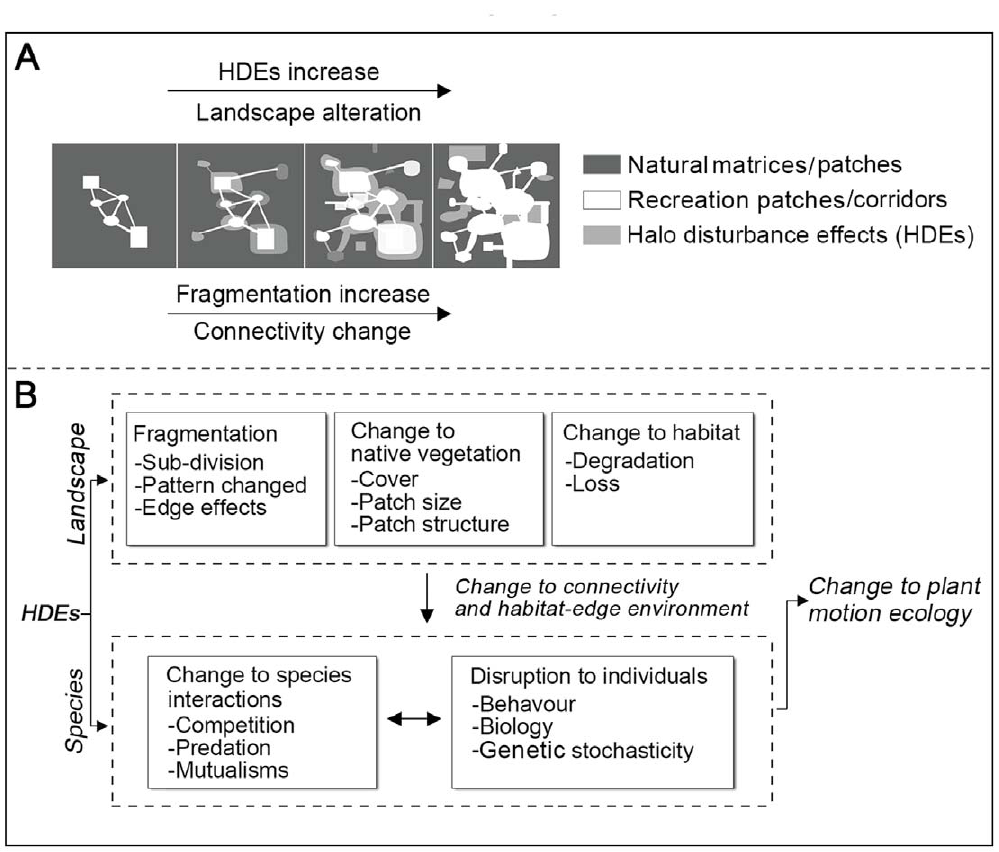
Figure 1. Conceptual framework of ‘‘Halo disturbance effects (HDEs)’’. A , prediction model of recreation landscape (RL) fragmentation (modified from [35]). B , HDEs can not only modify the structure and pattern of landscapes leading to the reduction of habitat area and the alteration of connectivity [36], but also produce ripple effects on species by disrupting mutualisms between species (modified from [37]).